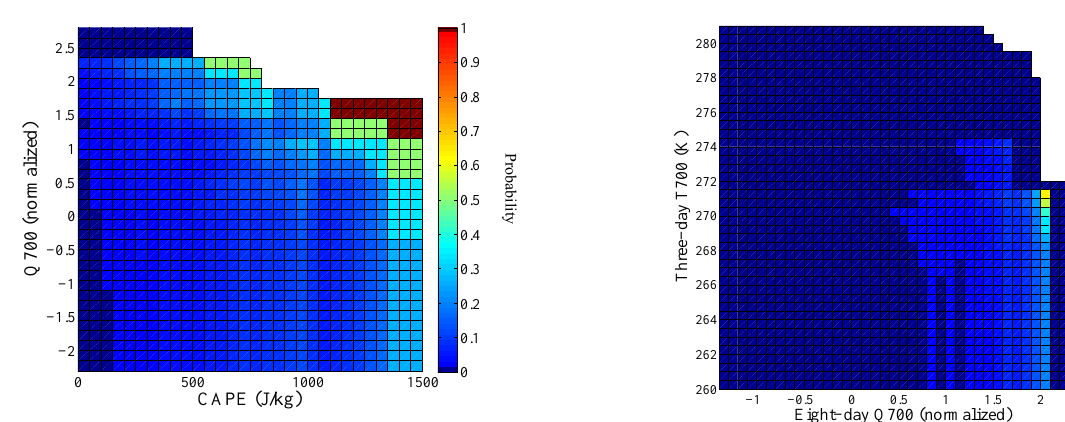
Figure 8. Probability of a flash event from spring synoptic rainfall based on 8-day mean specific humidity at 700hPa and 3-day mean temperature at 700hPa between 1989 and